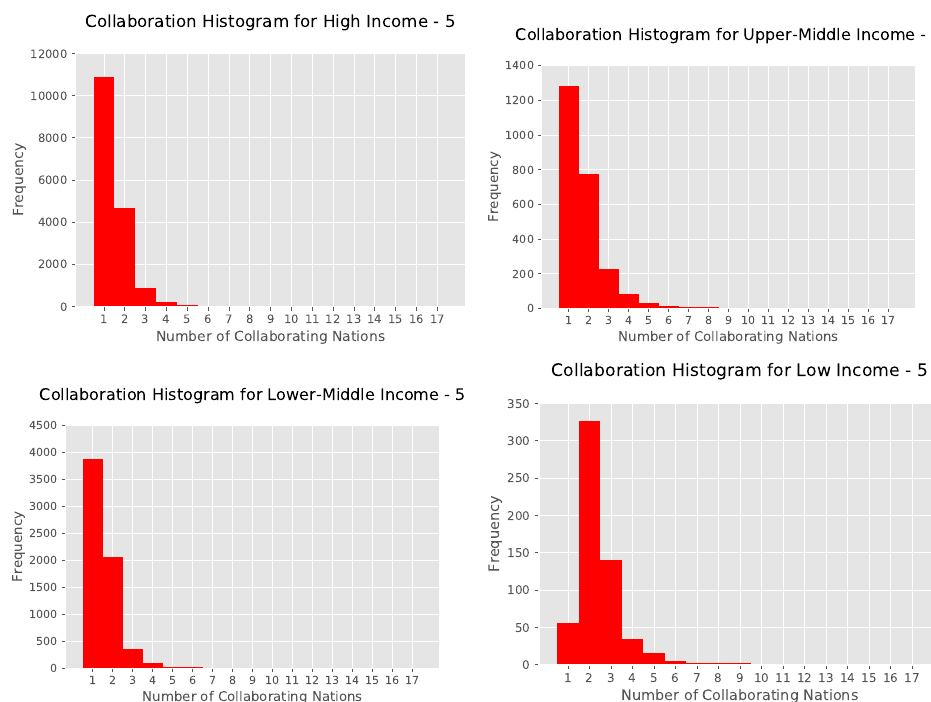
Figure 22. The distribution of distinct nations represented on papers in the social sciences by income group.